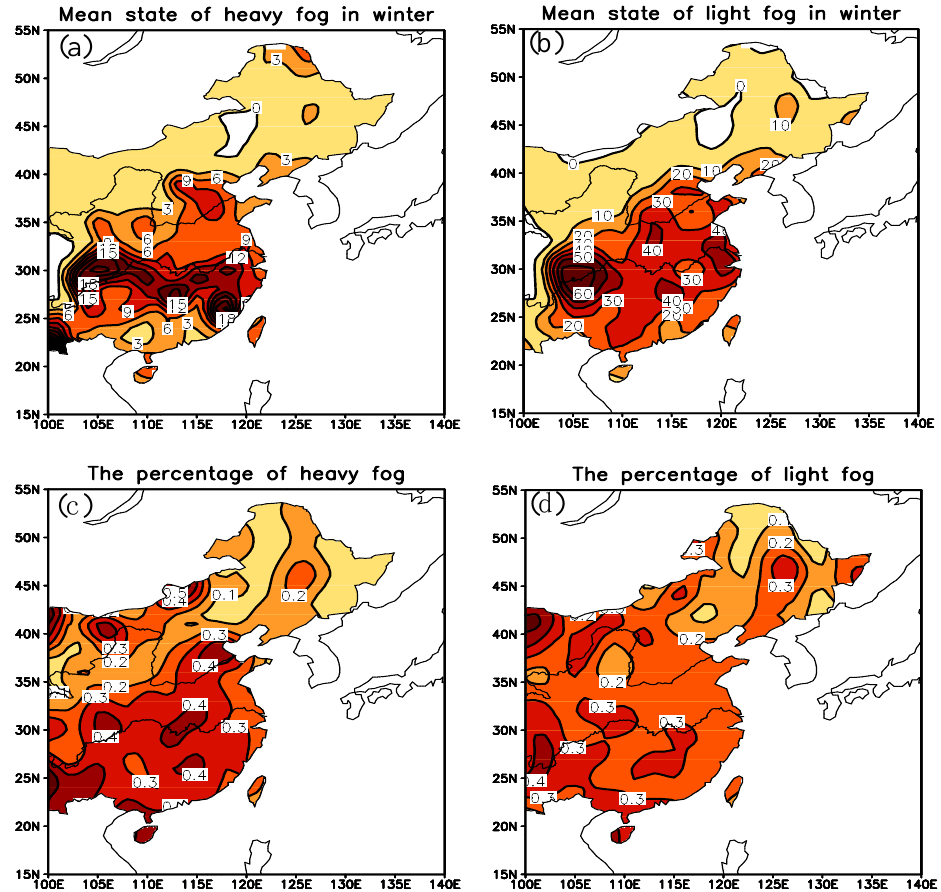
Figure 2. Climatology of winter fog days in east China during 1954–2007, respectively for ( a ) heavy fog and ( b ) light fog (unit: day). The ratio of winter fog days on the annual average with ( c ) heavy fog and ( d ) light fog.